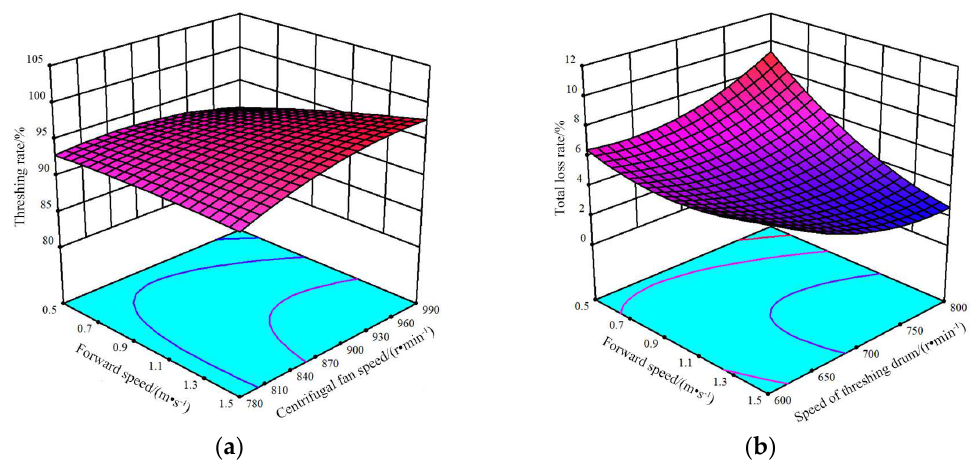
Figure 13. Influence of interaction factors on response values: ( a ) Effect of advancing speed and centrifugal fan speed on decontamination rate. ( b ) Effect of advancing speed and threshing drum speed on total loss rate.